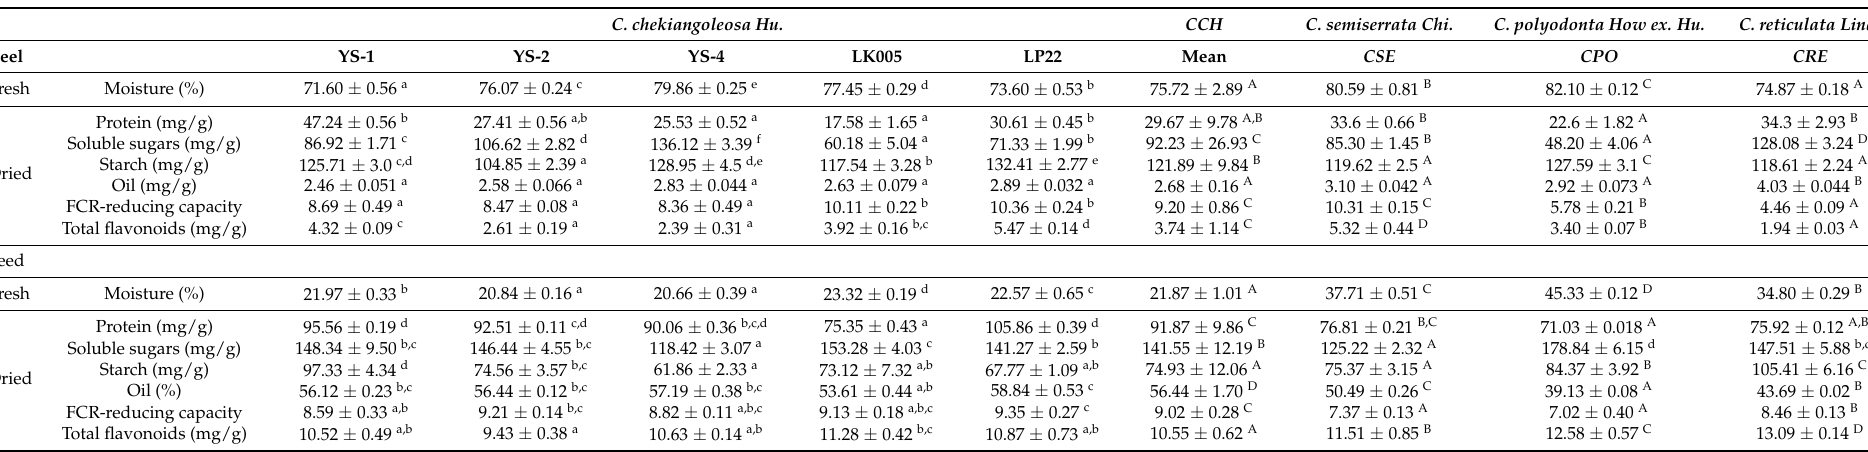
Table 2. Chemical composition of camellia seed/peel depending on different species.